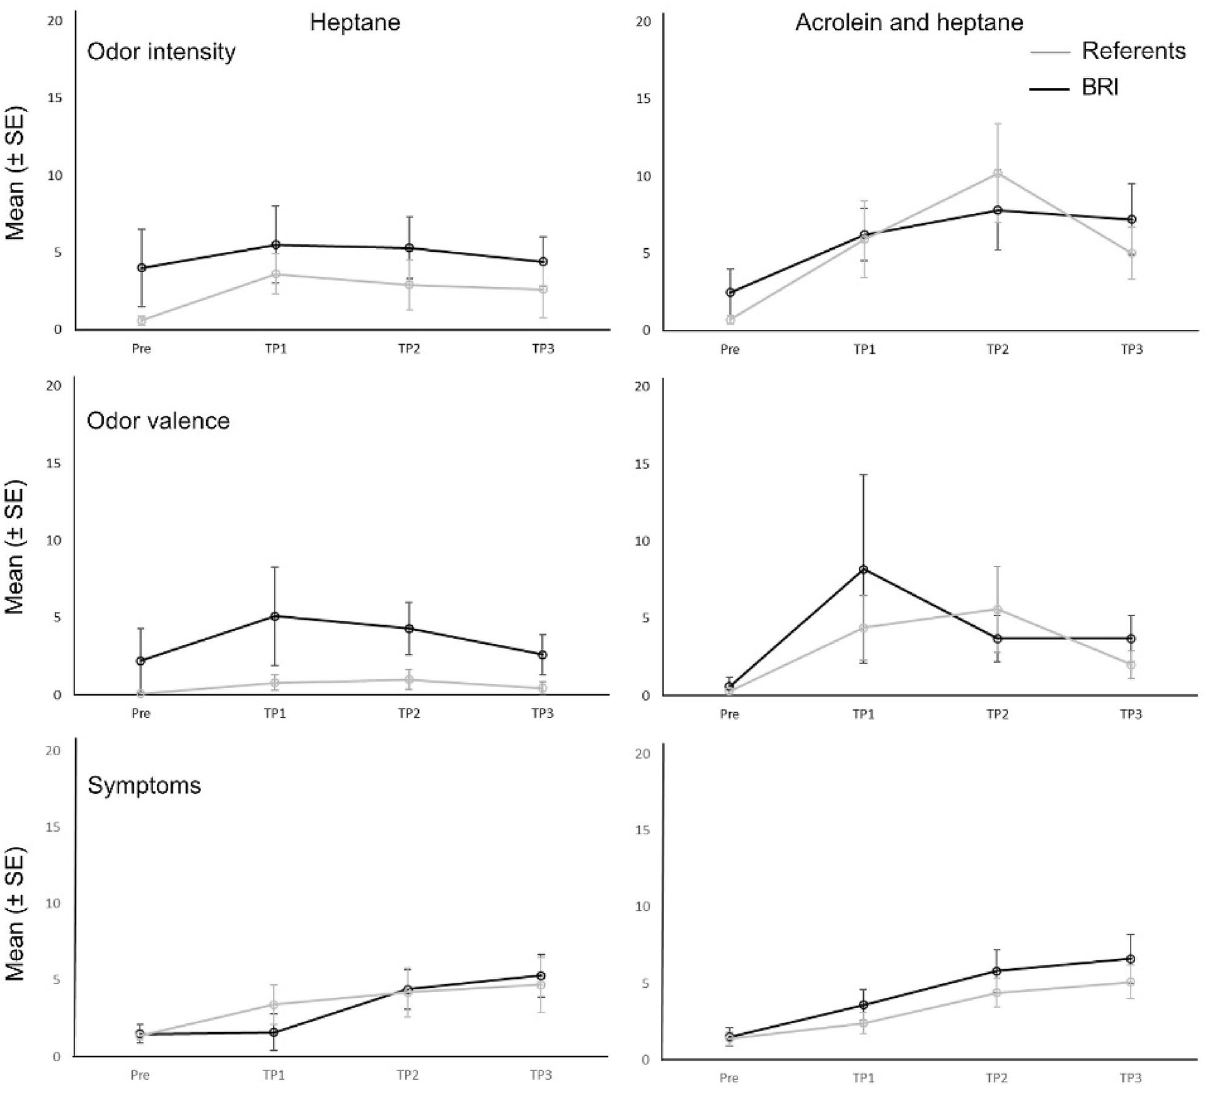
Figure 1. The mean ratings (Mean ± SE) of perceived odor intensity, valence, and ratings of symptoms for the referents and the group with building related intolerance, at four time points during exposure to heptane alone and acrolein and heptane.